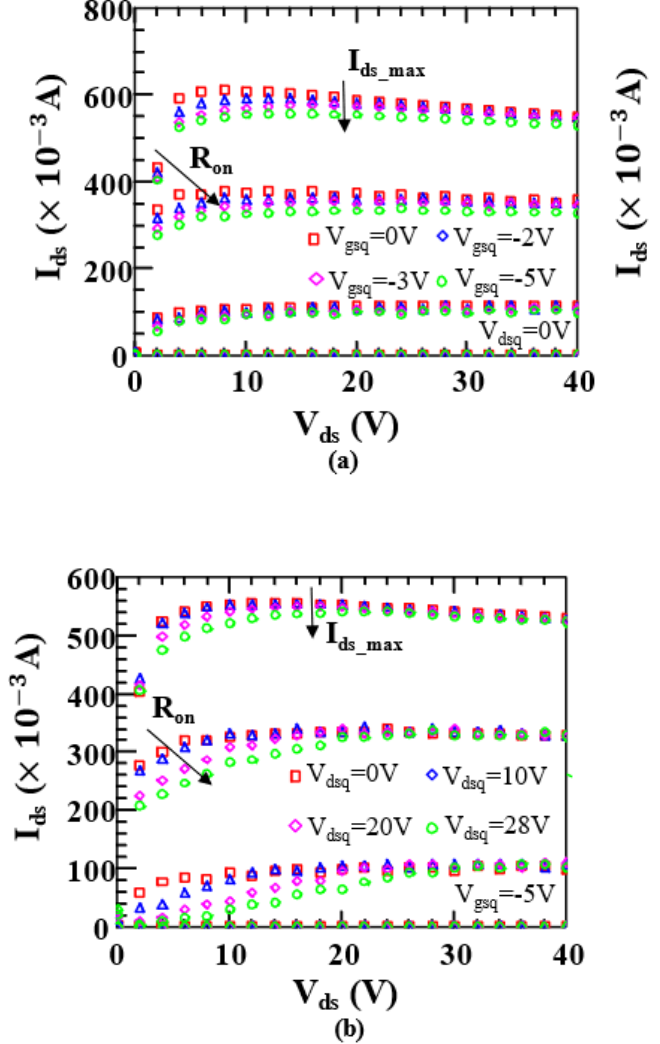
Figure 3. Measured pulsed output characteristics under ( a ) different gate quiescent bias voltages V gsq and ( b ) different drain quiescent bias voltages V dsq . The gate voltage V gs ranges from − 3 V to 0 V with a step size of 1 V.